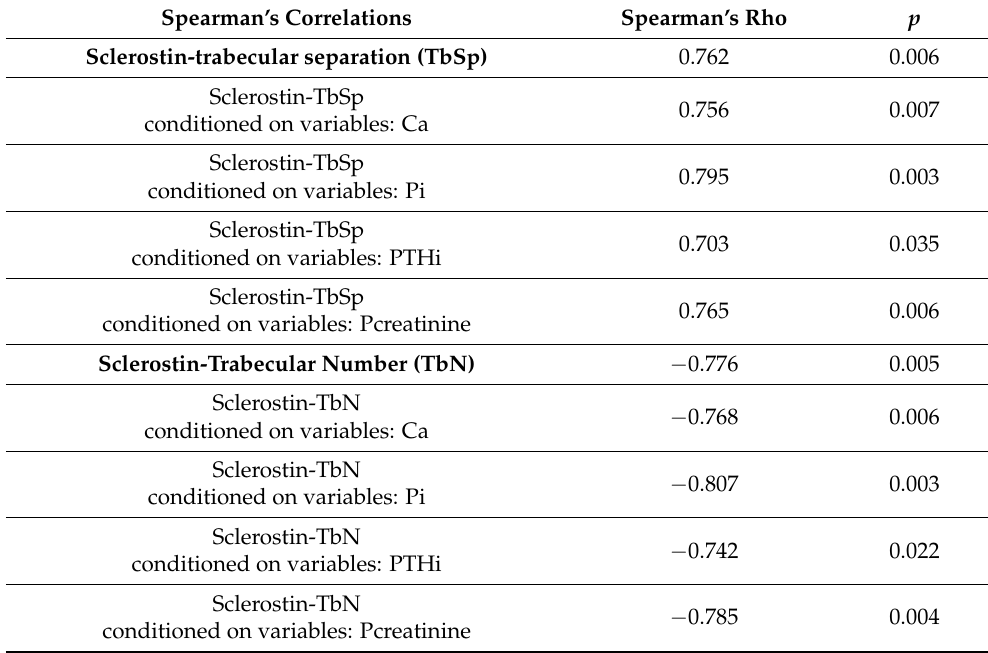
Table 4. Partial correlation between sclerostin levels and bone biopsy parameters, with controlling of the effect of other variables.